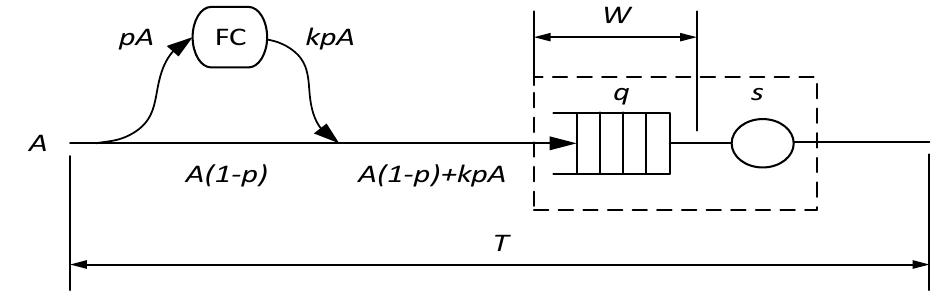
Figure 5. The traffic service model.